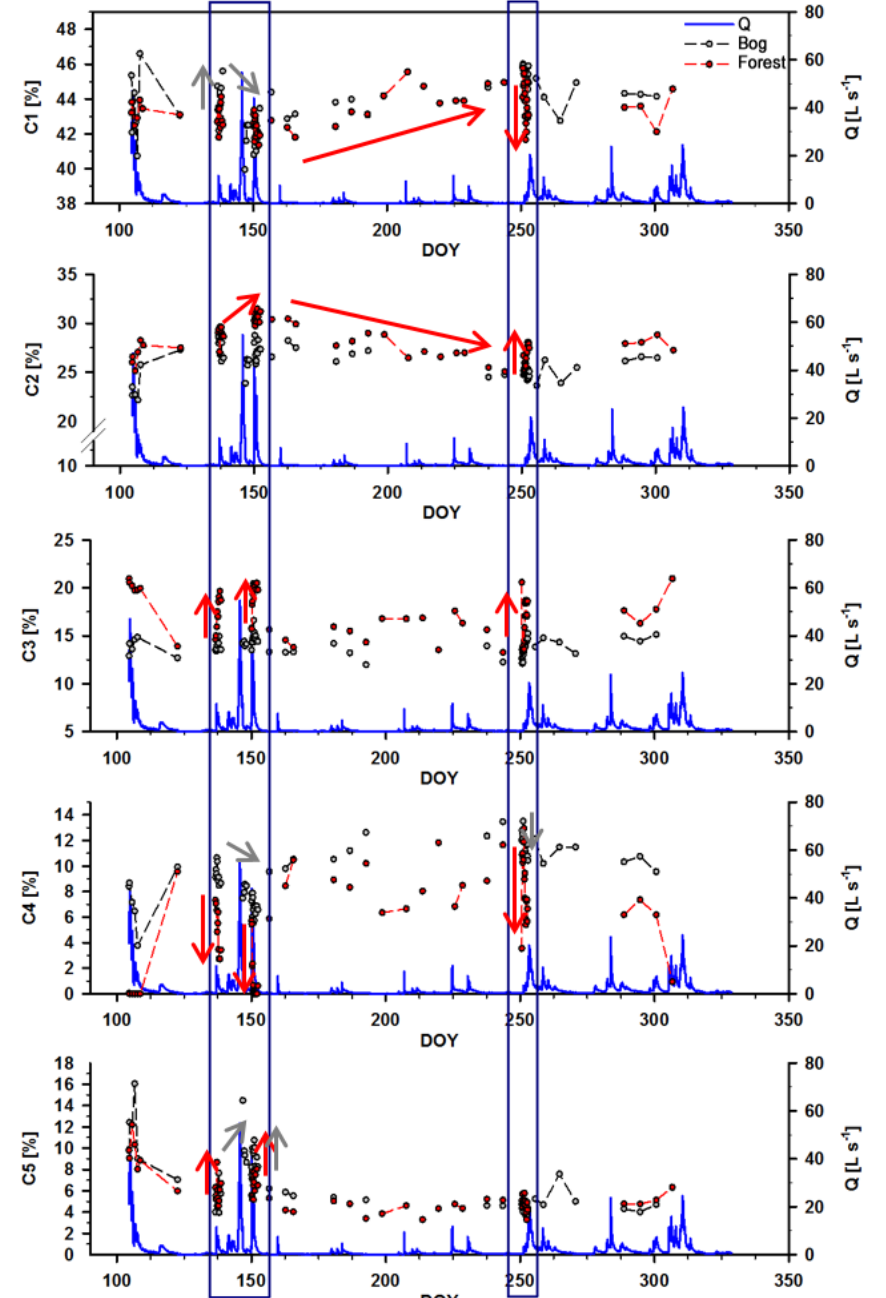
Figure 6. Percentage of PARAFAC components C1–C5. Blue line represents the bog discharge ( Q ). Grey dots indicate bog site values, red dots forest site values, while arrows indicate trends during rain events and summer drought at the different sites. Sampled rain events in spring and fall are